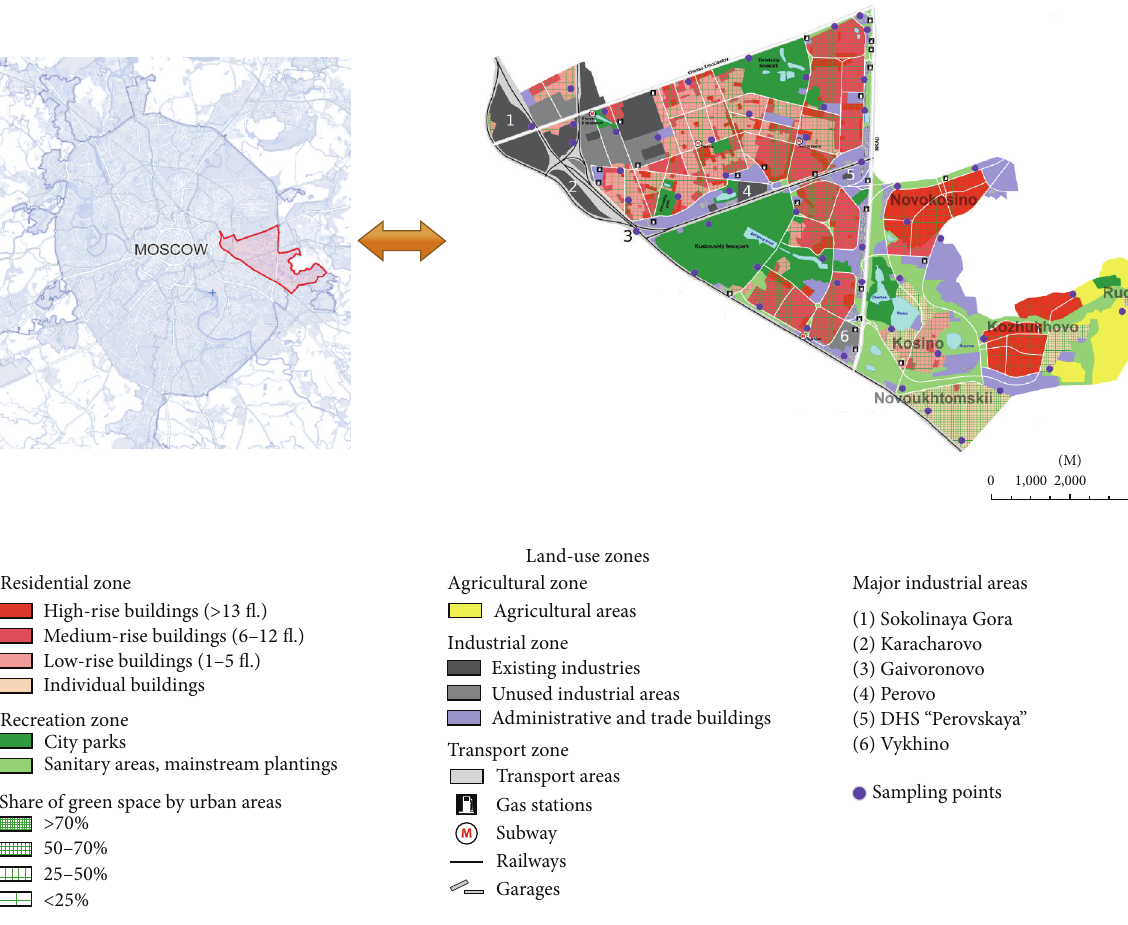
Figure 1: The map of land-use zones for the territory of the Eastern district of Moscow